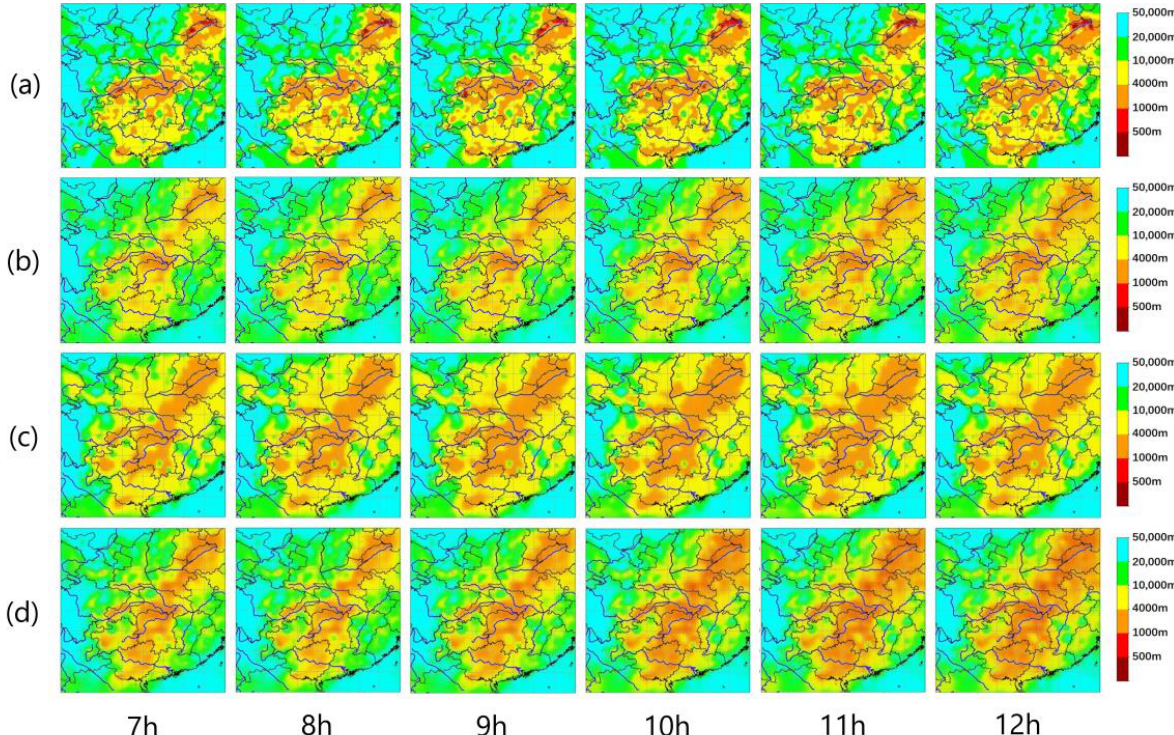
Figure 6. Observed and predicted images on 31st October 2020 (18:00–23:00). ( a ) Observed; ( b ) ConvLSTM; ( c ) PredRNN; ( d ) SwiftRNN.